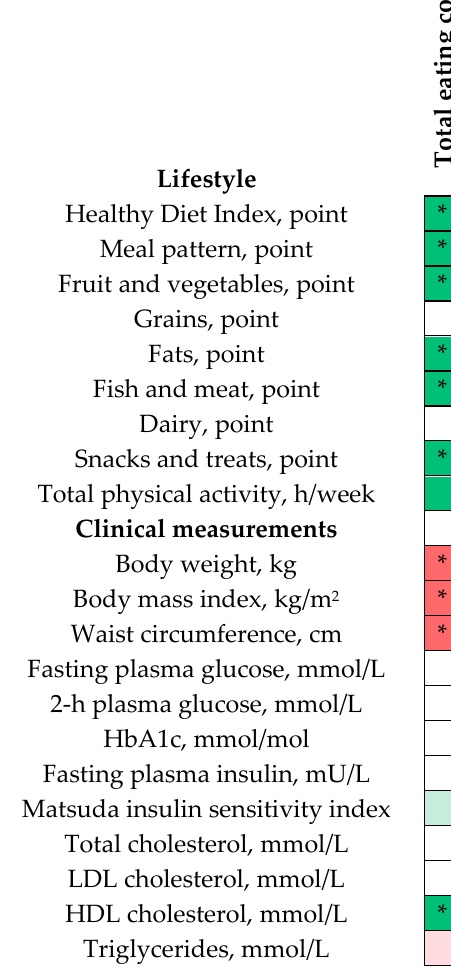
Figure 2. The associations of changes in eating competence (EC) total scores and its sub-scores with Healthy Diet Index, total physical activity and clinical measurements from linear mixed-effects models adjusted for age, sex, study province, educational level, and study group x follow-up time interaction. * The associations were statistically significant after further adjustment for corresponding EC score at baseline. 2-h plasma glucose from oral glucose tolerance test.